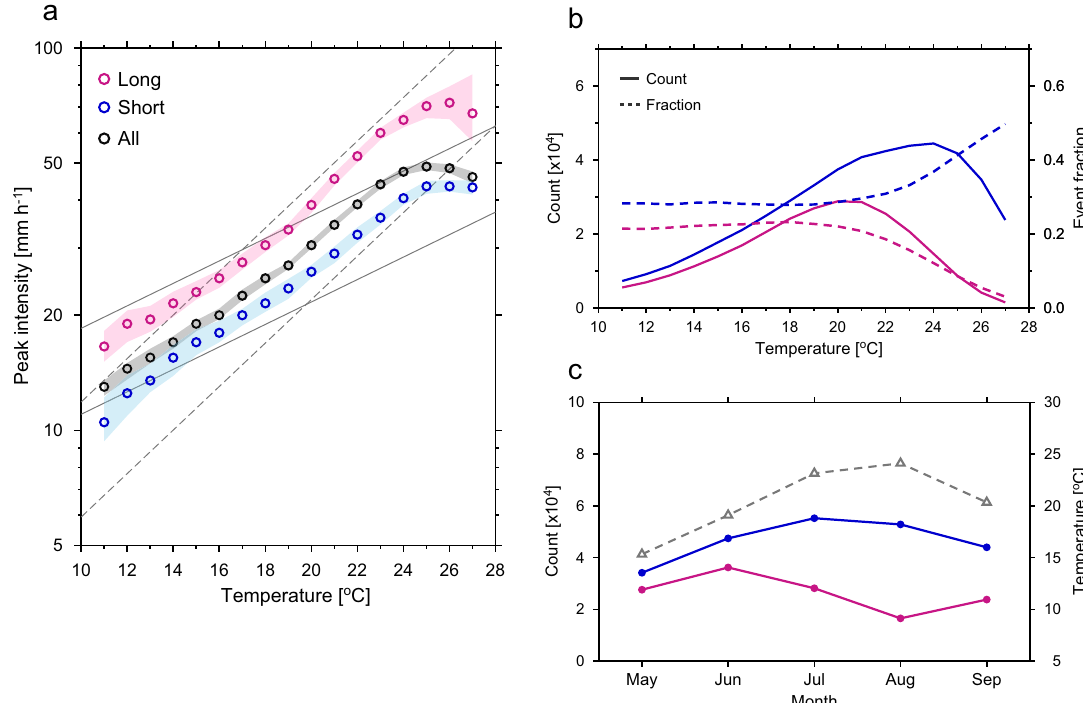
Fig. 3 The relationship between surface air temperature and extreme hourly precipitation. a The 99th percentile of event peak hourly precipitation as a function of daily mean surface temperature for long-duration (red), short-duration (blue), and all (black) events. Solid and dashed lines indicate 7%°C − 1 and 14% °C − 1 rates, respectively. A logarithmic vertical axis is used. Shaded areas denote the 95% con fi dence intervals estimated using the bootstrap method (see ‘ Methods ’ ). The estimated scaling rates are 11.1% °C − 1 , 9.8% °C − 1 , and 9.7% °C − 1 for long-duration, short-duration, and all events, respectively. b Count (solid lines) of long (red)- and short (blue)-duration events and their fraction of all events (dashed lines) in each temperature bin. Note that the total fraction of long- and short-duration events is below 1.0, because all events also include mid-duration (5 – 10h) events and short-duration events with morning peak intensity. c Monthly count of the two types of events (solid lines). As a reference, the grey dashed line indicates the climatology of the surface temperature over the whole of Japan using data from all 646